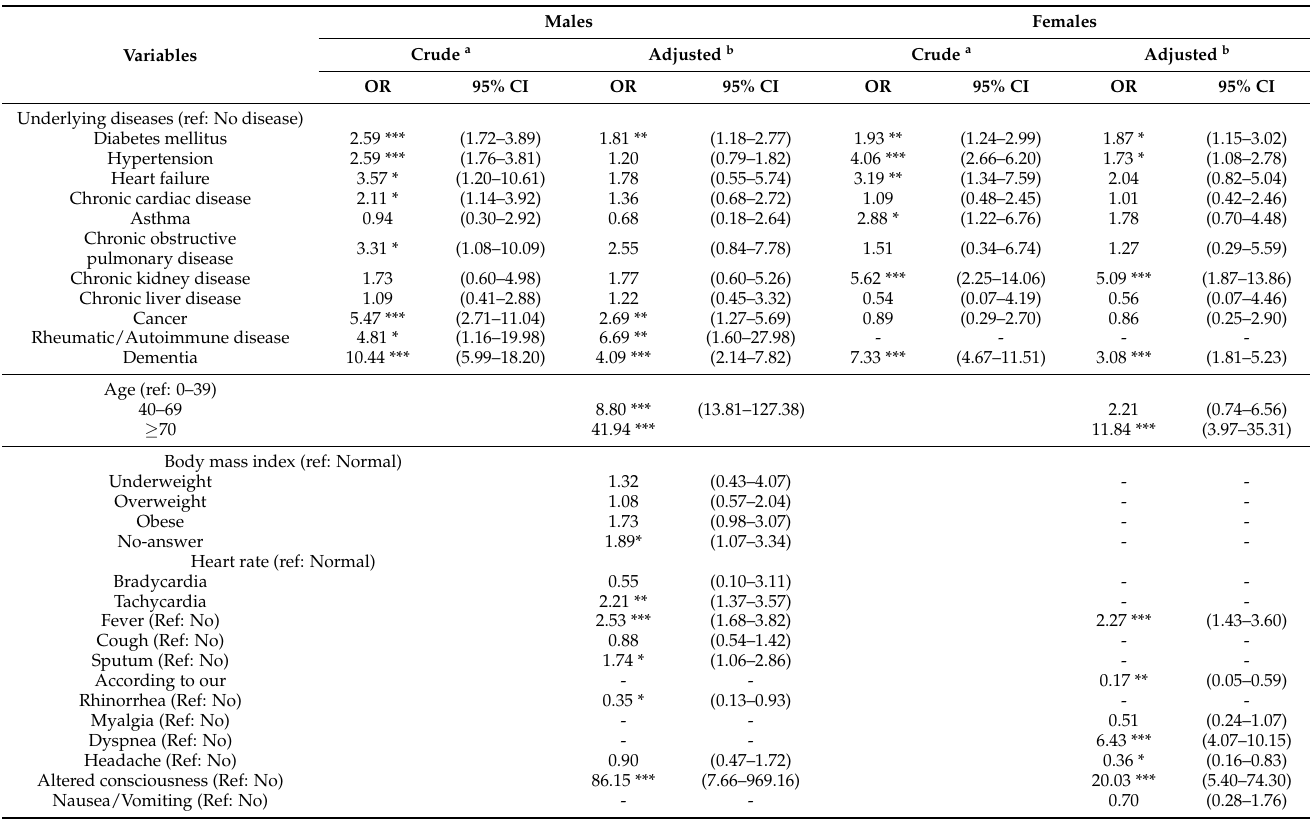
Table 3. The associations between underlying diseases and the clinical severity by